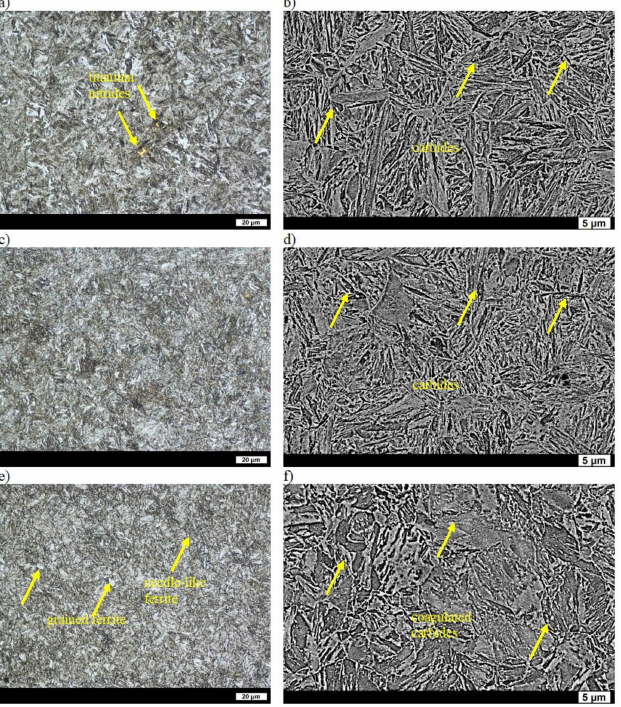
Figure 10. Microstructure of ingot No. 8 after quenching and tempering: ( a ) at 200 ◦ C, LM; ( b ) at 200 ◦ C, SEM; ( c ) at 400 ◦ C, LM; ( d ) at 400 ◦ C, SEM; ( e ) at 600 ◦ C, LM; ( f ) at 600 ◦ C, SEM. Etched with 3% HNO 3